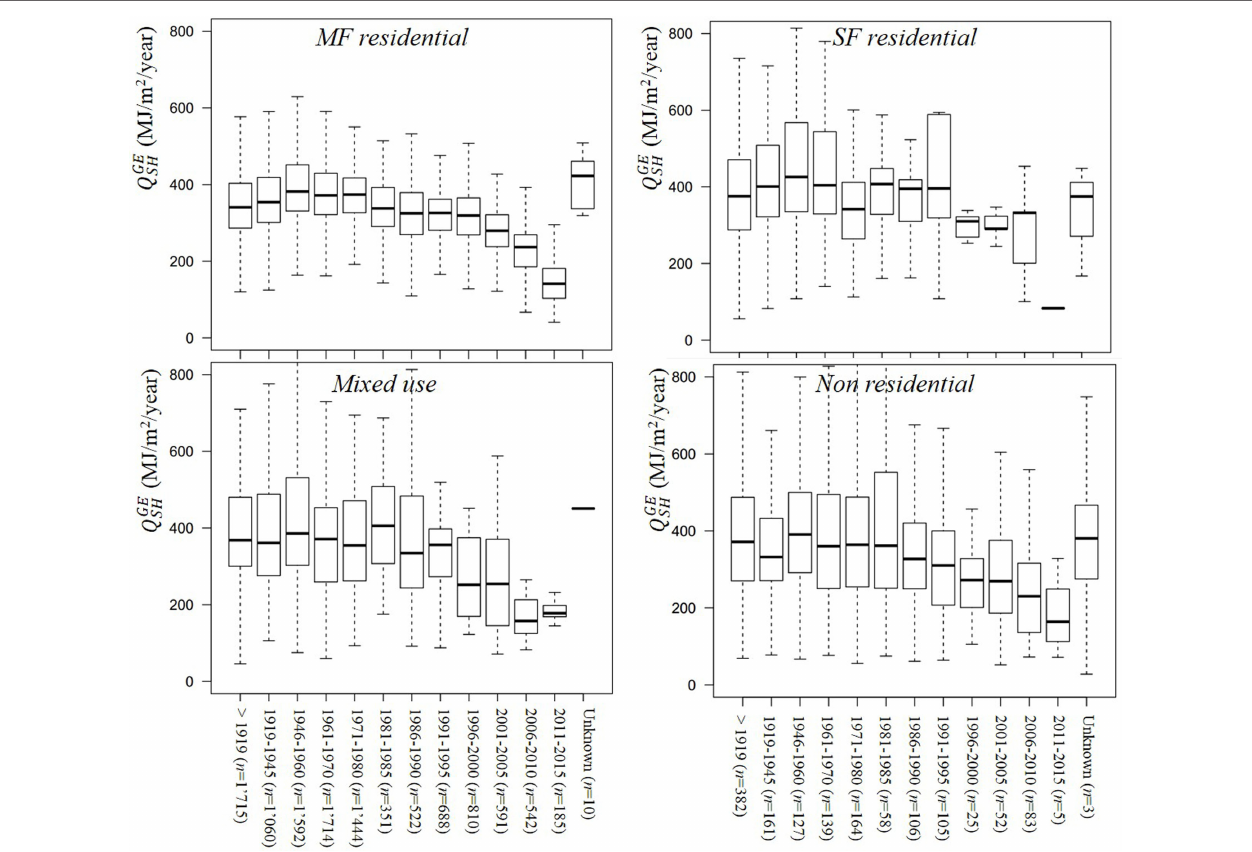
FIGURE 4 | Boxplot distribution of Q GE SH by construction period and building category (SITG IDC database).